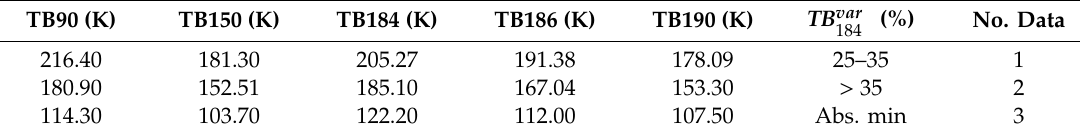
Table 6. Average TBs defining the dynamic range for hail